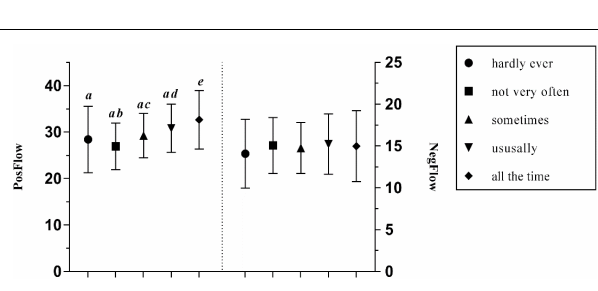
FIGURE 10 | The effects of teacher’s frequency of FL use on PosFlow and NegFlow (Means and significant Differences).